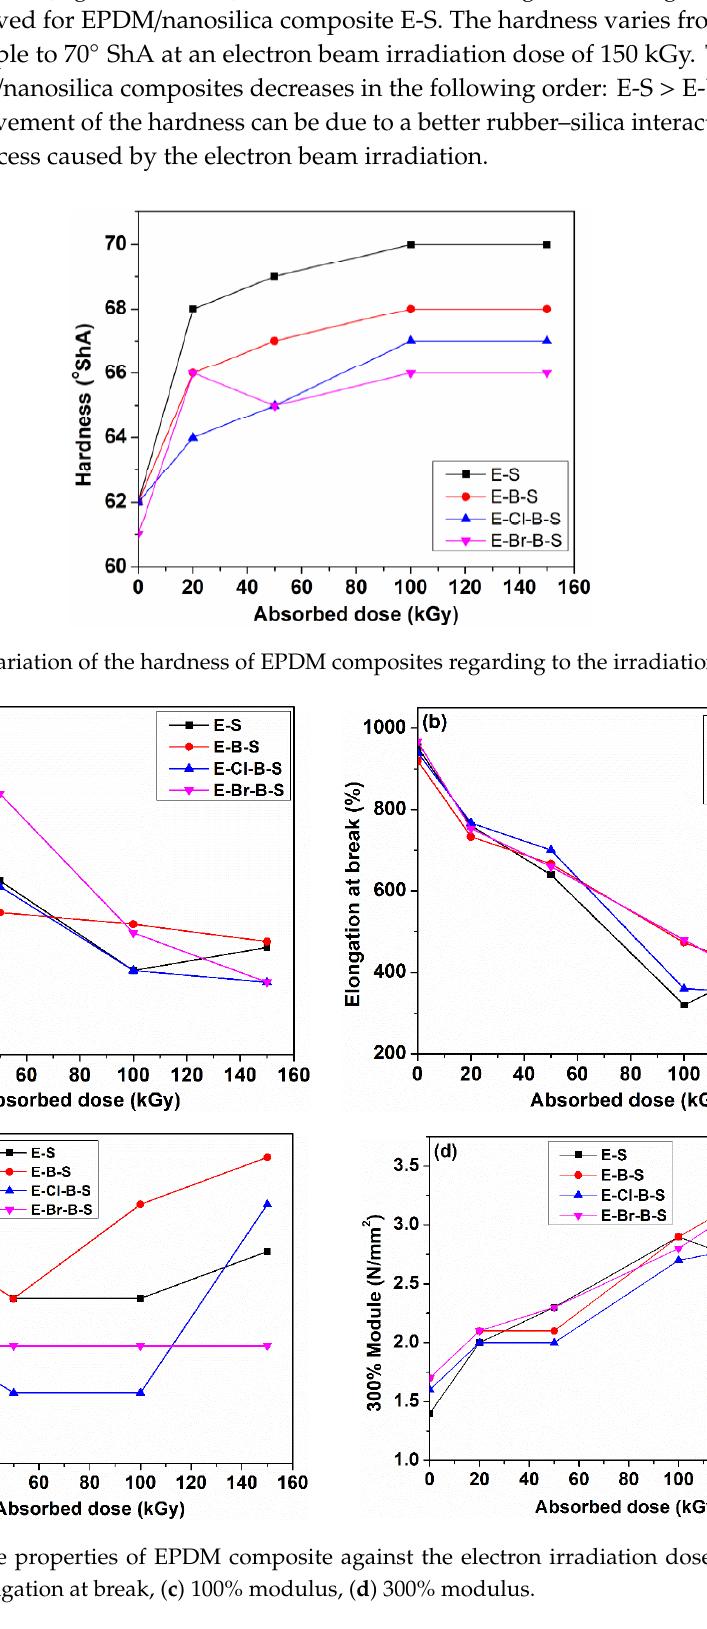
Figure 3. Elongation set at different electron beam irradiation dose. Figure 4. Elasticity as a function of irradiation dose.